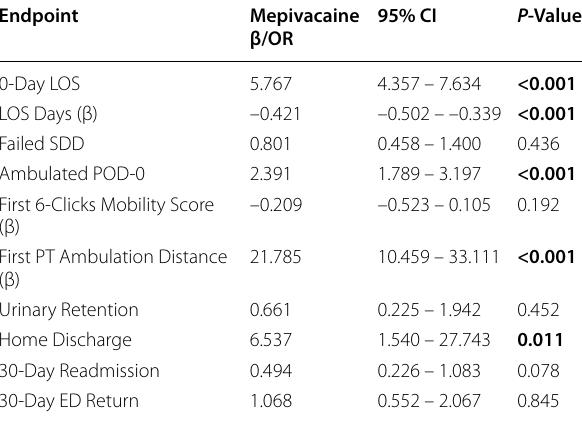
P -values <0.05 in